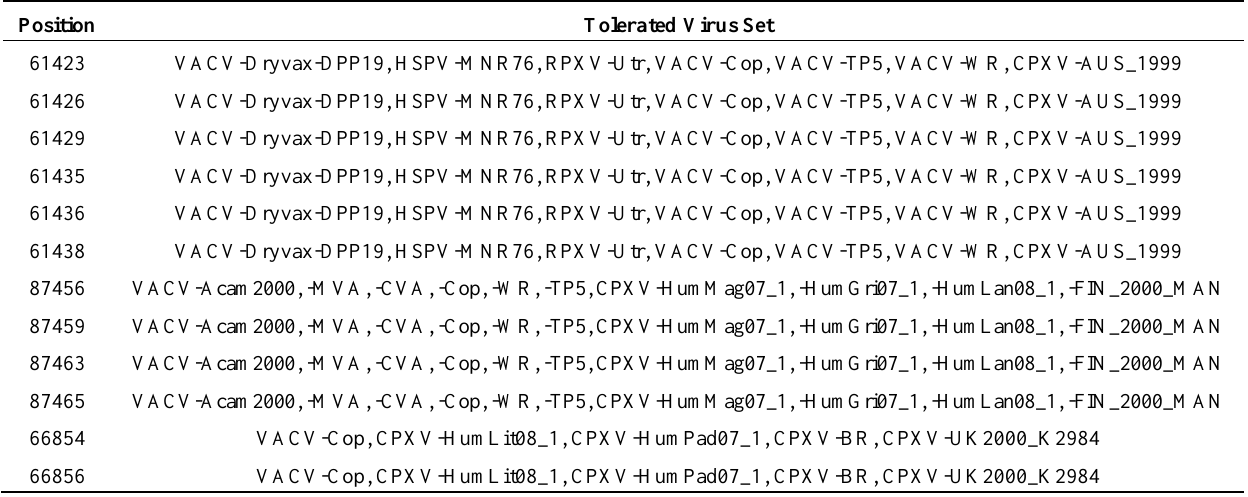
Table 3. Positions of SNPs where the three VACV-Lister strains are identical and all other sequences are different, with Tolerance of